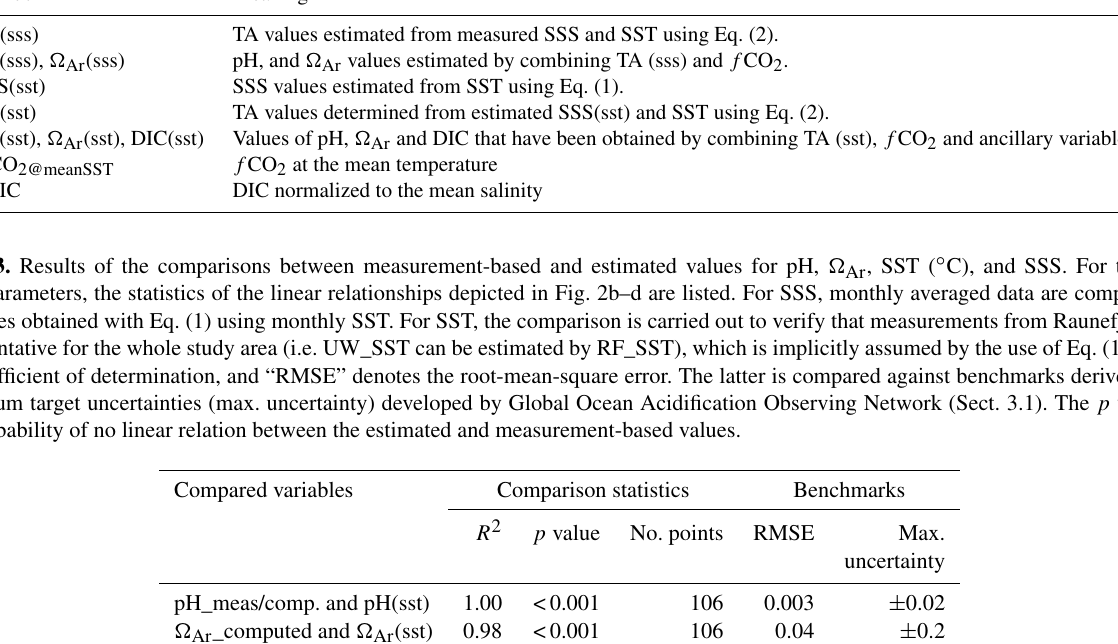
Table 2. Overview of the symbols used for quantities estimated and/or derived from the measurement-based variables SSS, SST, TA, pH, DIC, f CO 2 , and (cid:127) Ar . Symbol Meaning TA values estimated from measured SSS and SST using Eq. (2).